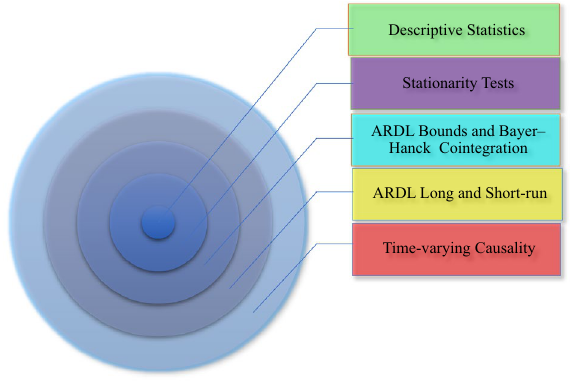
Figure 2. Flow of the study.